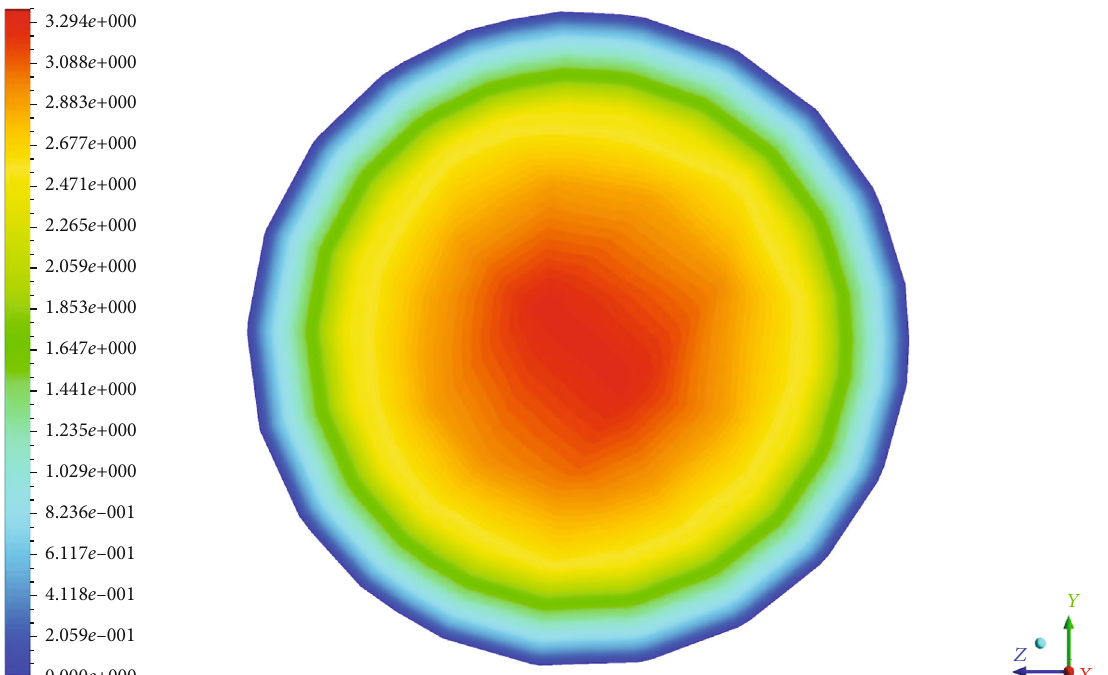
Figure 7: Velocity contour of the observation plane X = 7m